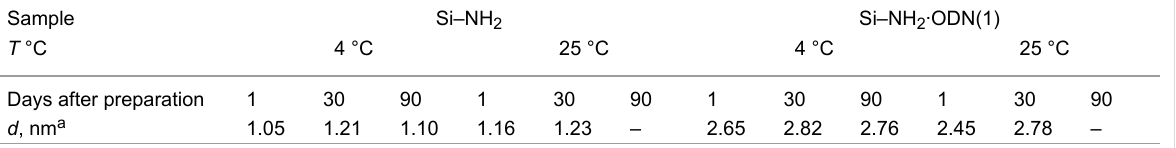
Table 2: Diameter of Si–NH 2 and Si–NH 2 ·ODN complexes at different times after preparation. Sample